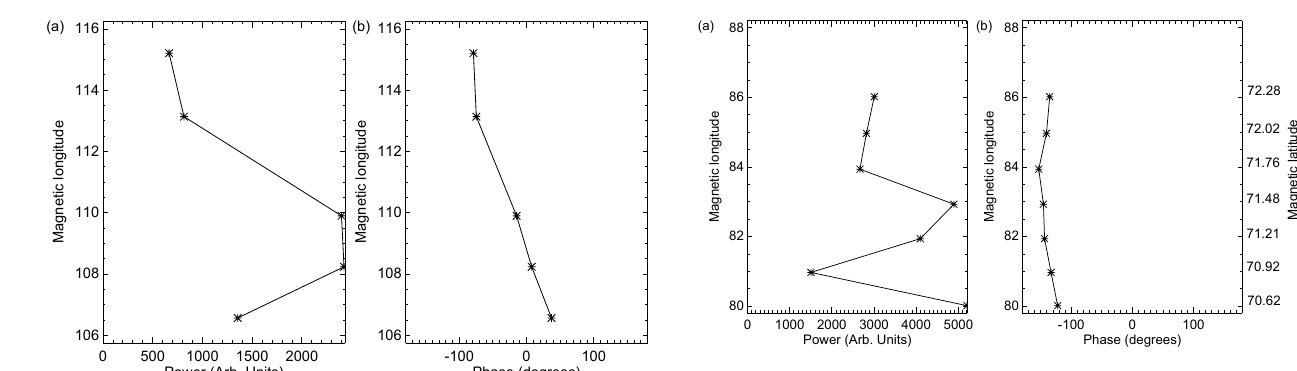
Fig. 7. Fourier (a) power and (b) phase at the peak frequency of the ULF wave observed in the ionospheric drift velocity measured along beam 5 of the Þykkvibær SuperDARN radar as a function of geomagnetic longitude. The corresponding geomagnetic latitudes of the datapoints are shown on the right for